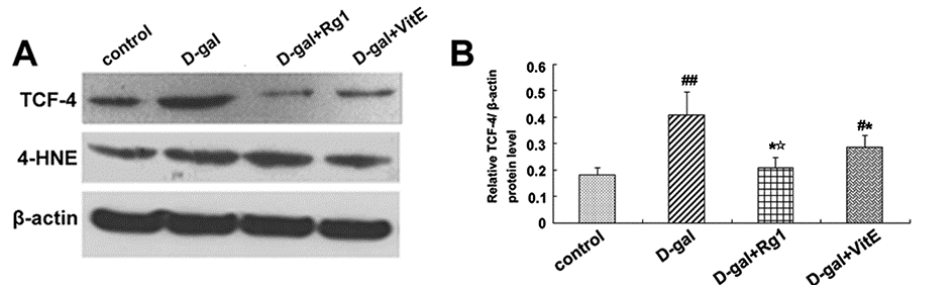
Figure 5. Cont. Figure 5. Cont.